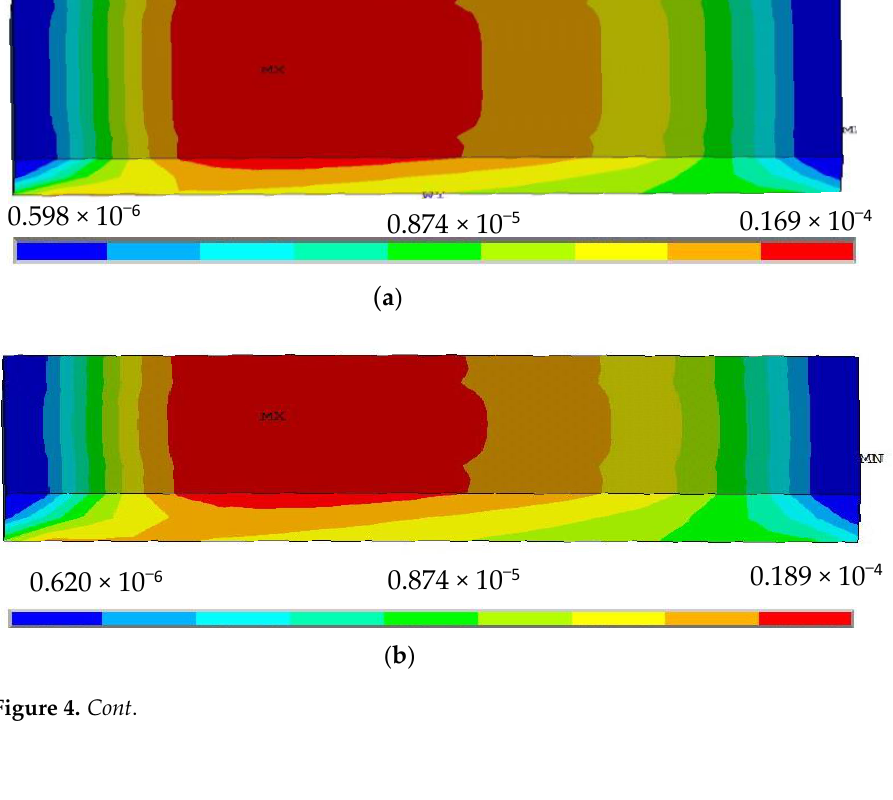
Table 2. Variation of the silica gel width.